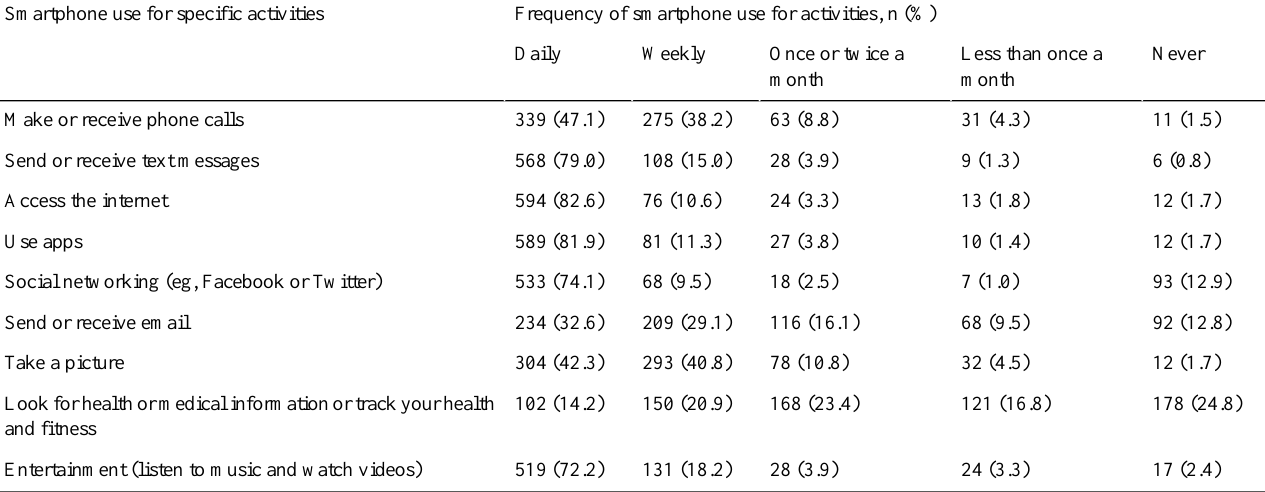
Table 2. Frequency of smartphone use for specific activities (n=719).